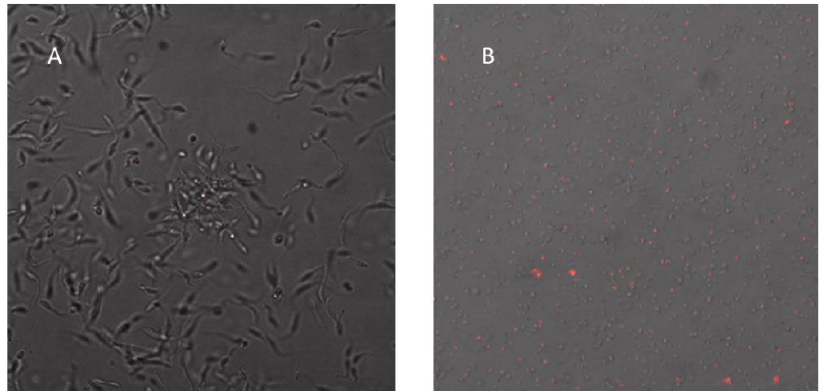
Figure 6. Nuclear and cytoplasmic membrane disruption of T. cruzi after ergosterol peroxide treatment. The confocal microscopy images are shown at 1000 × ( A ) the control, untreated T. cruzi ; ( B ) T. cruzi treated with 20 µM ergosterol peroxide for 24 h.